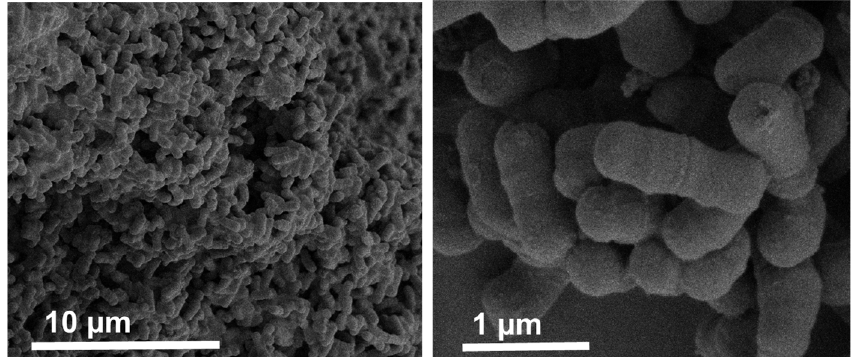
Figure 1. SEM images of free Bifido cells at different magnifications. The size and the morphology of the electrosprayed ETC core–shell capsules loaded with Bifido are shown in Figure 2. Overall, the core–shell microcapsules revealed a dimpled structure morphology, which resembles the morphology of electrosprayed ETC-based capsules [14]. The lack of spherical structure of these particles could be related with the fast evaporation of the solvent, as both ethanol and acetone are highly volatile solvents. Electrosprayed capsules with smoother and spherical-like surfaces can be obtained using solvents with a lower evaporation rate